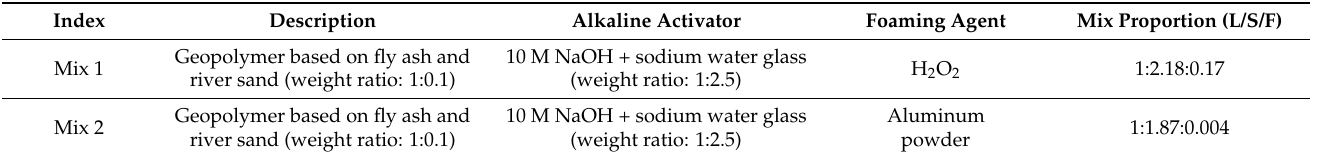
Table 1. The proportion of geopolymer mass.